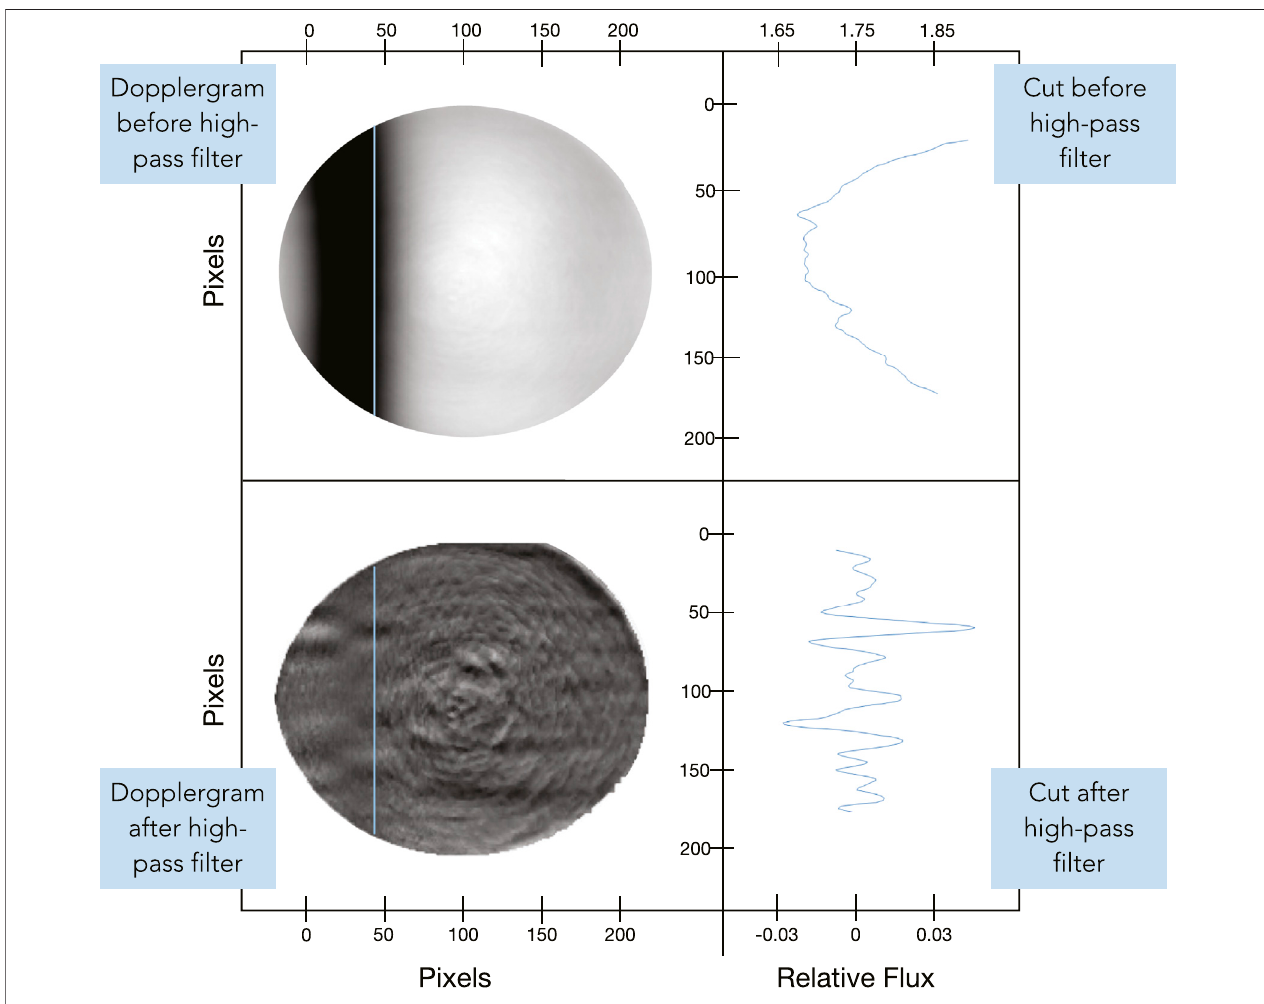
FIGURE7| Thetop-leftimageshowsanightly-averagedDopplergrambeforehigh-pass fi ltering.Thetop-rightplotcontainstheprojectedinformationfromtheblue cut in the un fi ltered image. The bottom-left images shows a nightly-averaged Dopplergram after high-pass fi ltering. The bottom-right plot contains the projected information from the blue cut in the fi ltered image. The images are displayed with the N-pole facing the top of the fi gure. Plots have been normalized and scaled — indicated by the axis labels.